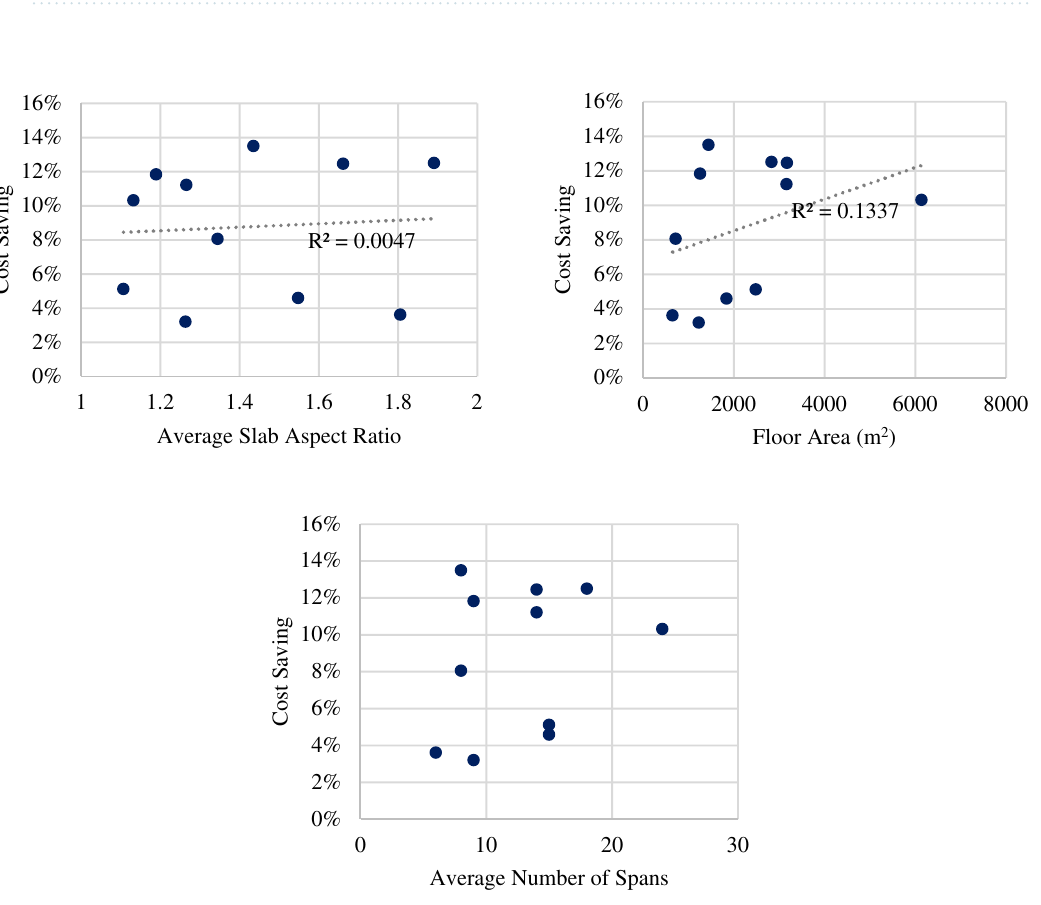
Figure 12. Sensitivity of the cost saving (bubble size) to the population size and number of iterations.